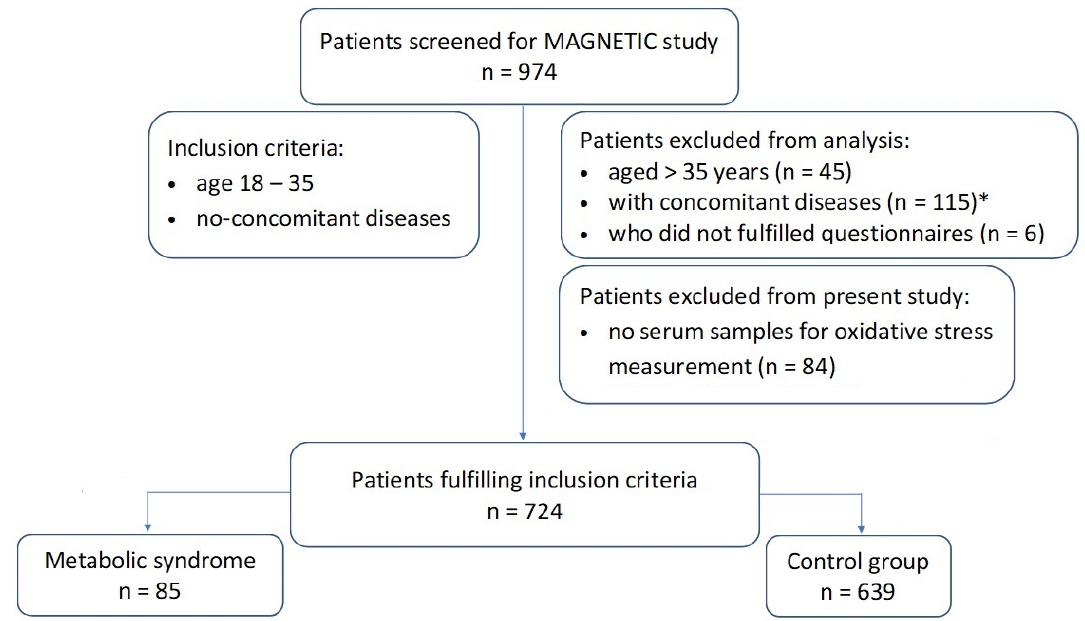
Figure 1. Study flowchart. Notes: * asthma or allergies (14); atopic skin disease (2); bipolar disorder or depression (3); cholelithiasis (1); chronic gastritis (1); coeliac disease (1); colitis (2); Crohn’s disease (1); diabetes mellitus (1); epilepsy (2); history of gastric ulcers (1); GERD (7); gout (2); Hashimoto’s disease and hypothyroidism (31); hypercholesterolemia treated with statins (1); hyperprolactinemia (1); hypertension (13); idiopathic purpura (1); irritable bowel syndrome (5); lactation (1); lactose intolerance (1); Marfan syndrome (1); migraines (3); nephrolithiasis (3); non-infectious hepatitis (1); polycystic ovarian disease (9); psoriasis (2); steatosis hepatitis (1); virial hepatitis (3).